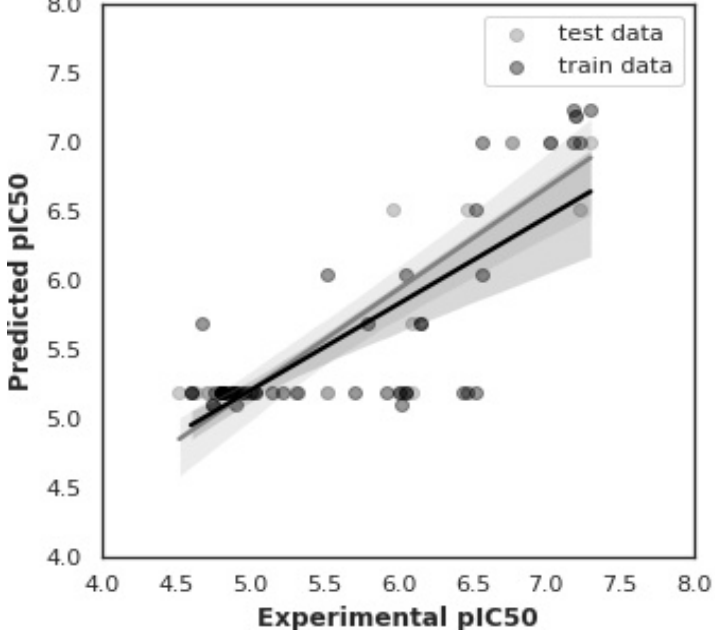
Figure 3. Experimental versus predicted pIC50 using the ETR model for training and testing data.